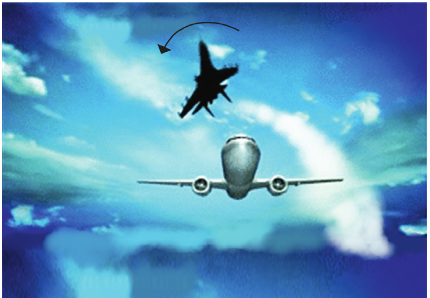
Figure 4: Barrel roll flight of an